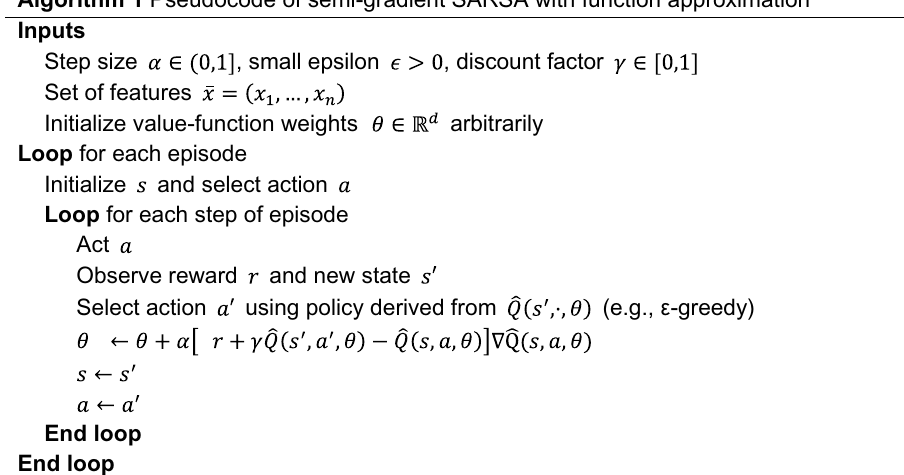
Algorithm 1 Pseudocode of semi-gradient SARSA with function approximation